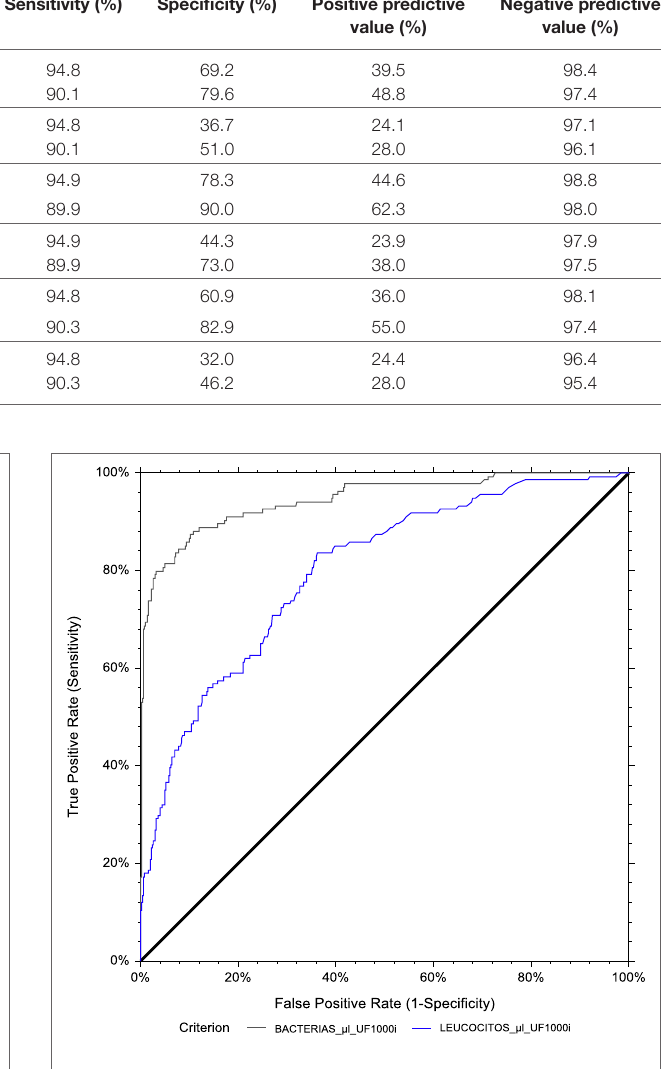
cut-off Sensitivity (%) Specificity (%) positive predictive the curve